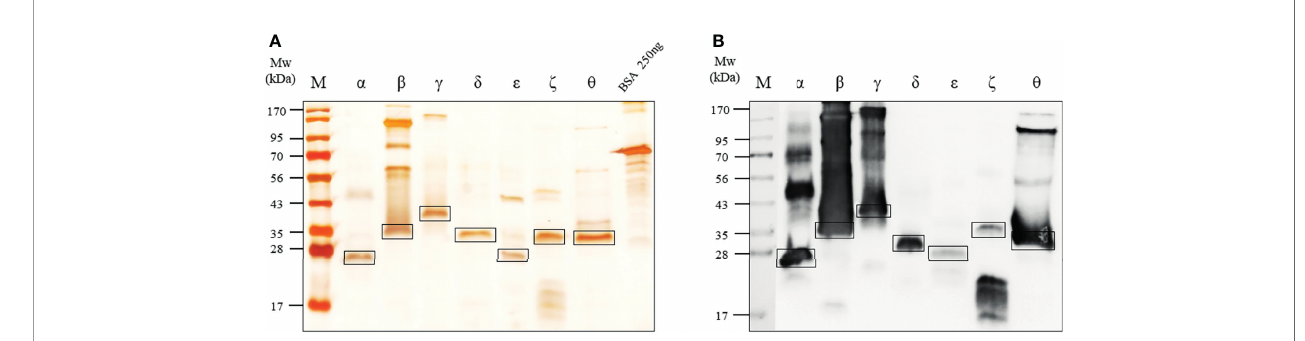
FIGURE 2 | Expression of seven rIL-32 isoform proteins. (A) 10% SDS-PAGE analysis followed by silver staining for the seven puri fi ed rIL-32 isoforms of rIL-32 after a multi-step puri fi cation procedure compared with a known concentration of bovine serum albumin. The molecular weight (kDa) and rIL-32 isoforms are indicated at the top of their respective lanes in the following arrangement: a , b , g , d , ϵ , z , and q . kDa; kilodalton. (B) Western blot analysis for seven rIL-32 proteins were loaded and probed with mouse anti-his 6 tag